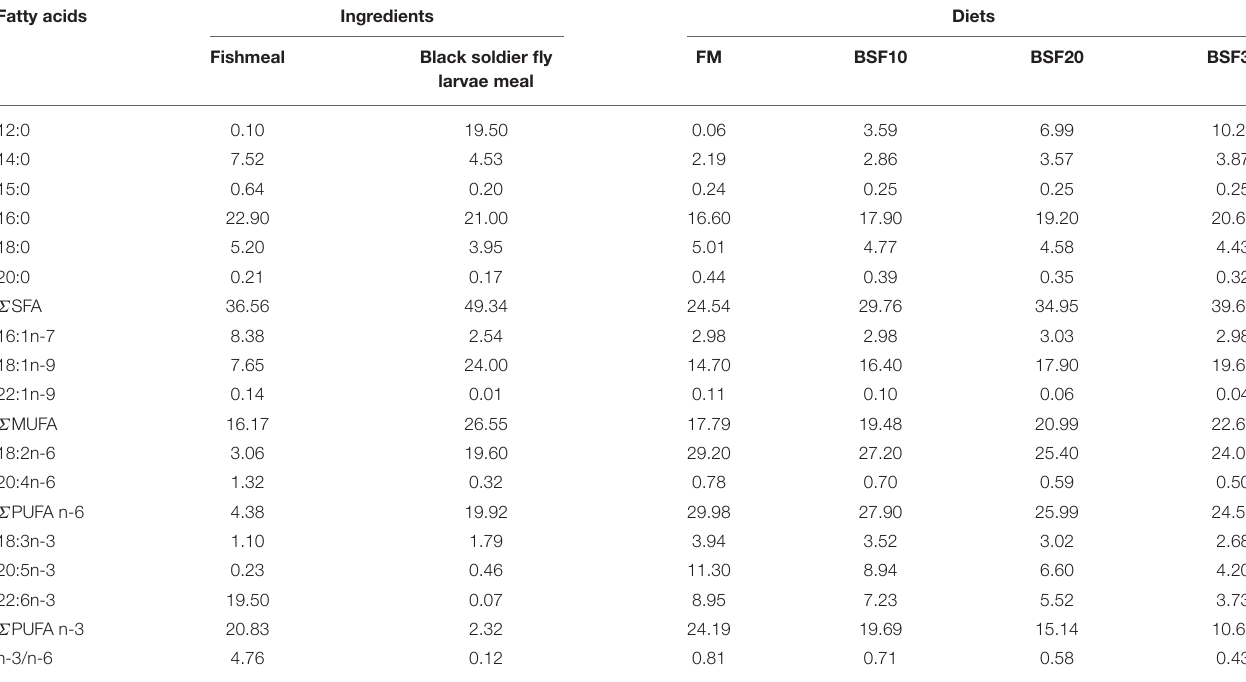
TABLE 3 | Fatty acid compositions of ingredients and diets (% of total fatty acids). Fatty